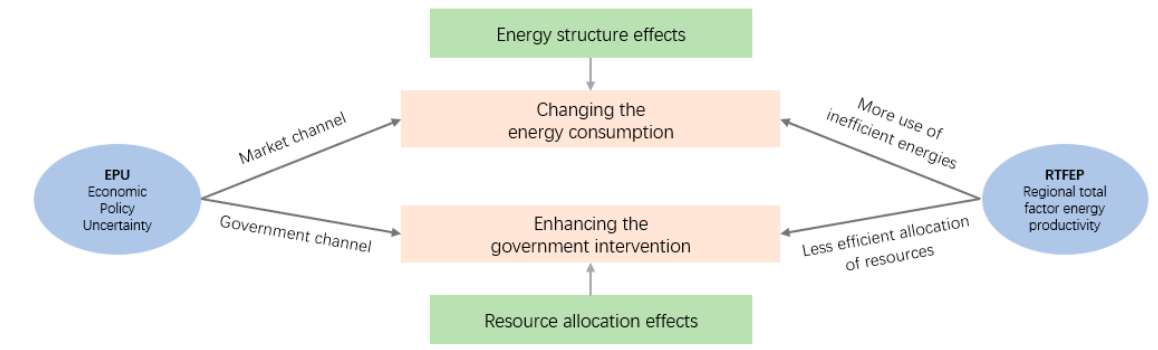
Figure 2. Theoretical framework.